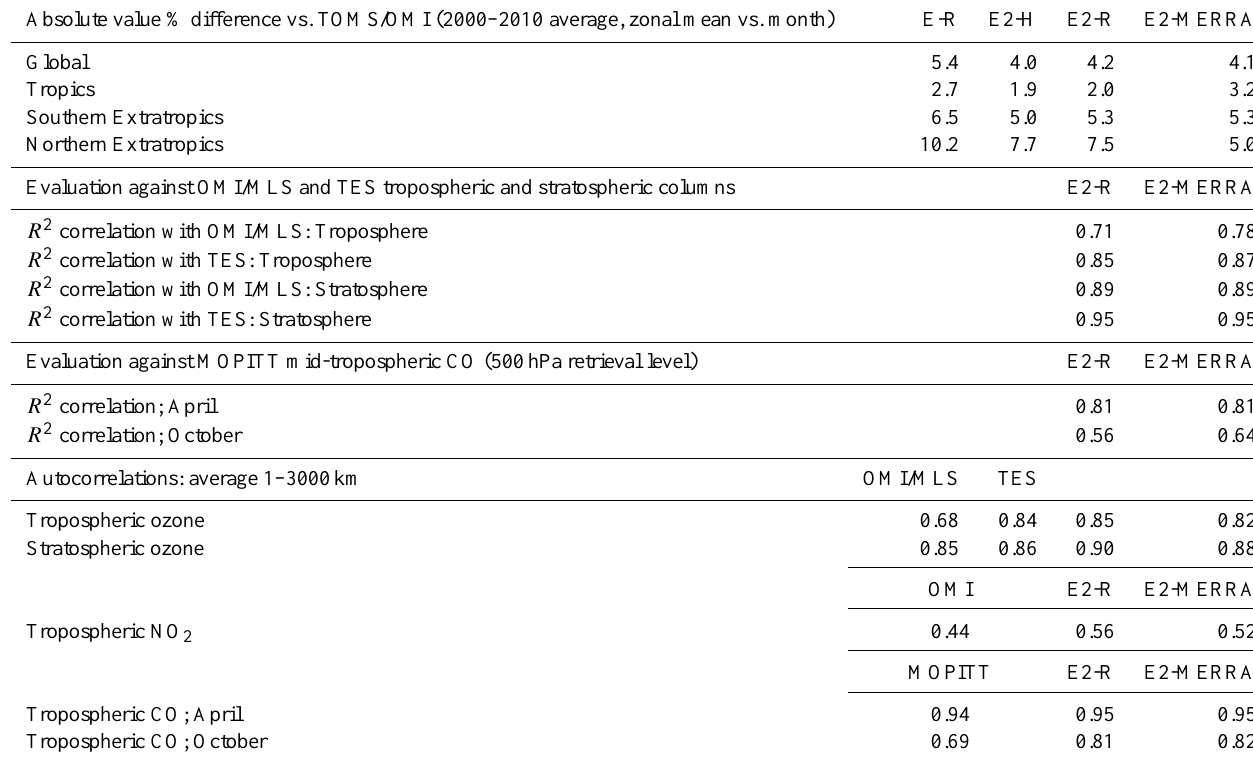
Table 2. Evaluation of model fields against satellite